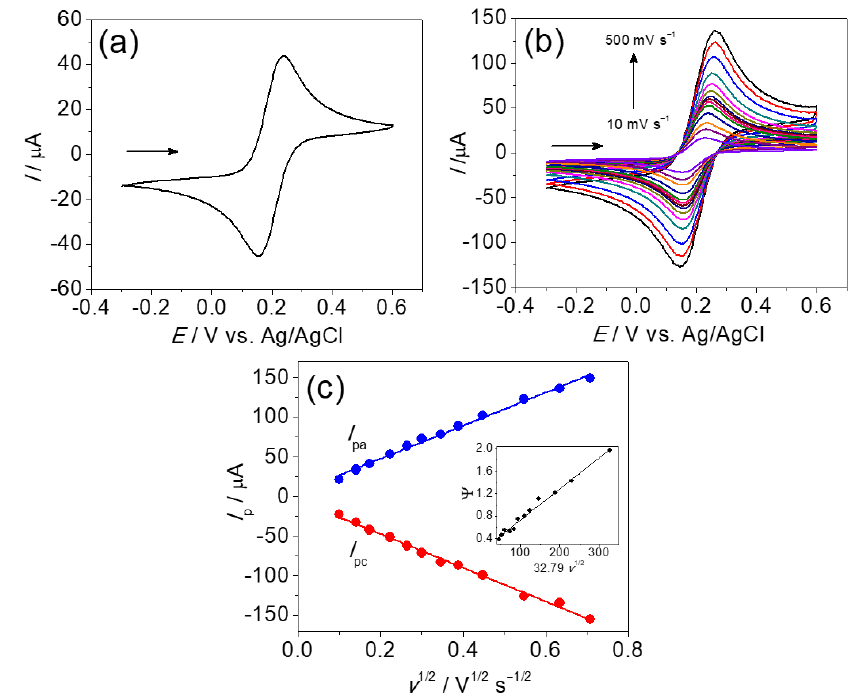
Figure 4. Cyclic voltammogram recorded at ( a ) 50 mV s −1 and ( b ) different potential scan rates (10–500 mV s −1 ) for 1.0 × 10 −3 mol L −1 K 3 Fe(CN) 6 in 0.1 mol L −1 KCl solution using the cathodically pretreated BDD electrode. ( c ) Plot of anodic ( I pa ) and cathodic ( I pc ) peak currents versus square root of scan rate ( v 1/2 ). Inset: plot of ψ vs. 32.79 v 1/2 .